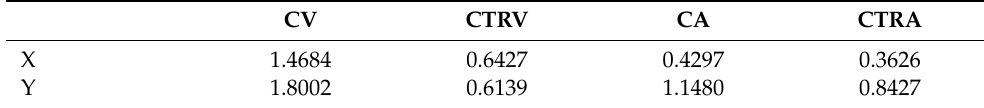
Table 8. RMSE of the models.